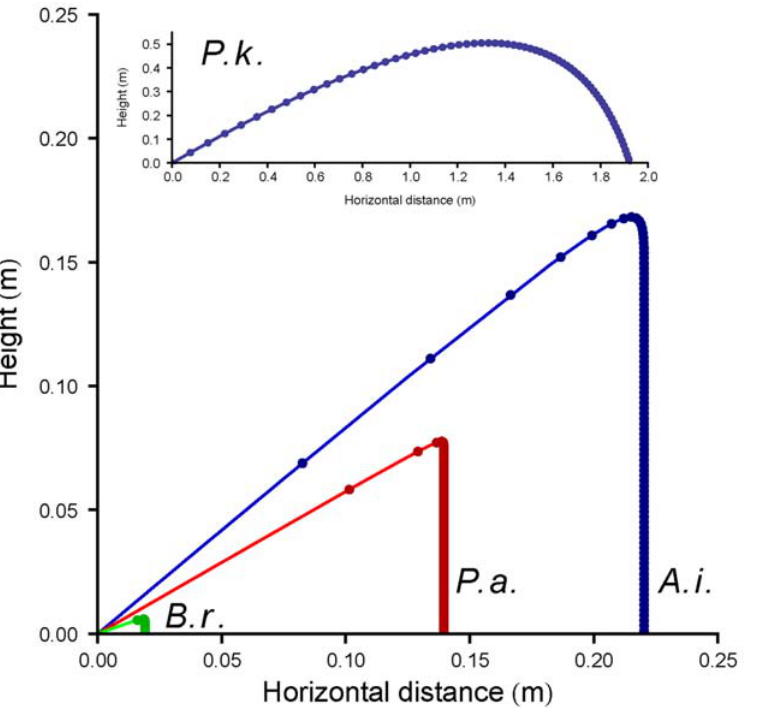
Figure 2. Predicted trajectories of spores and sporangia of four fungi based on launch data obtained by high speed video microscopy. Trajectories of spores and sporangia of Ascobolus immersus ( A.i. , blue), Podospora anserina ( P.a. , red), Basidiobolus ranarum ( B.r. , green), and Pilobolus kleinii ( P.k. , blue in inset). Points indicate projectile positions at 10 ms intervals. The truncated trajectories of A. immersus , P. anserina , and B. ranarum are indicative of the dominance of viscous forces over inertial forces in the motional regimes for these launches. Inertia is more significant for the flight of the larger sporangia of P. kleinii . Launch angles of 40 u ( A.i. ), 30 u ( P.a., P.k. ), and 20 u ( B.r. ), were chosen to separate the trajectories from one another but also reflect the phototropic orientation of these asci, sporangiophores, and conidiophores in nature.